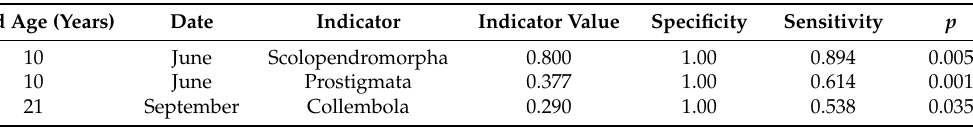
Table 3. Indicators for stand ages and overstory types.